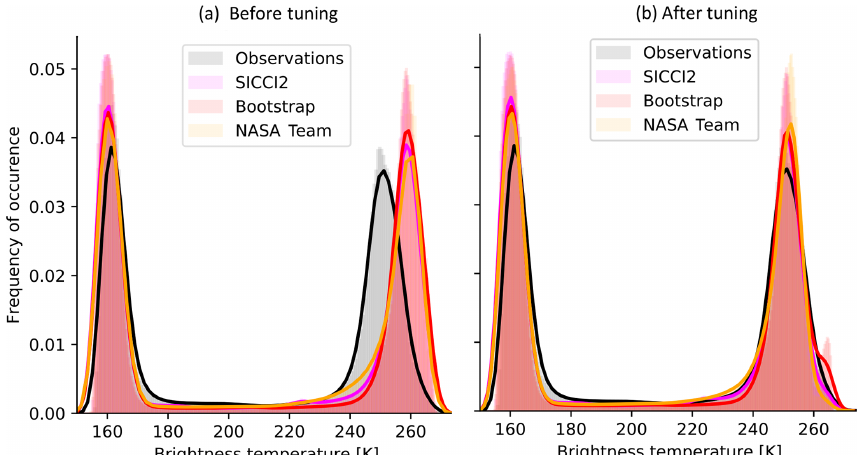
Figure A1. Density distribution of the brightness temperatures in the three simulated cases and in observations in the untuned (a) and tuned (b) version for the years 2005 to